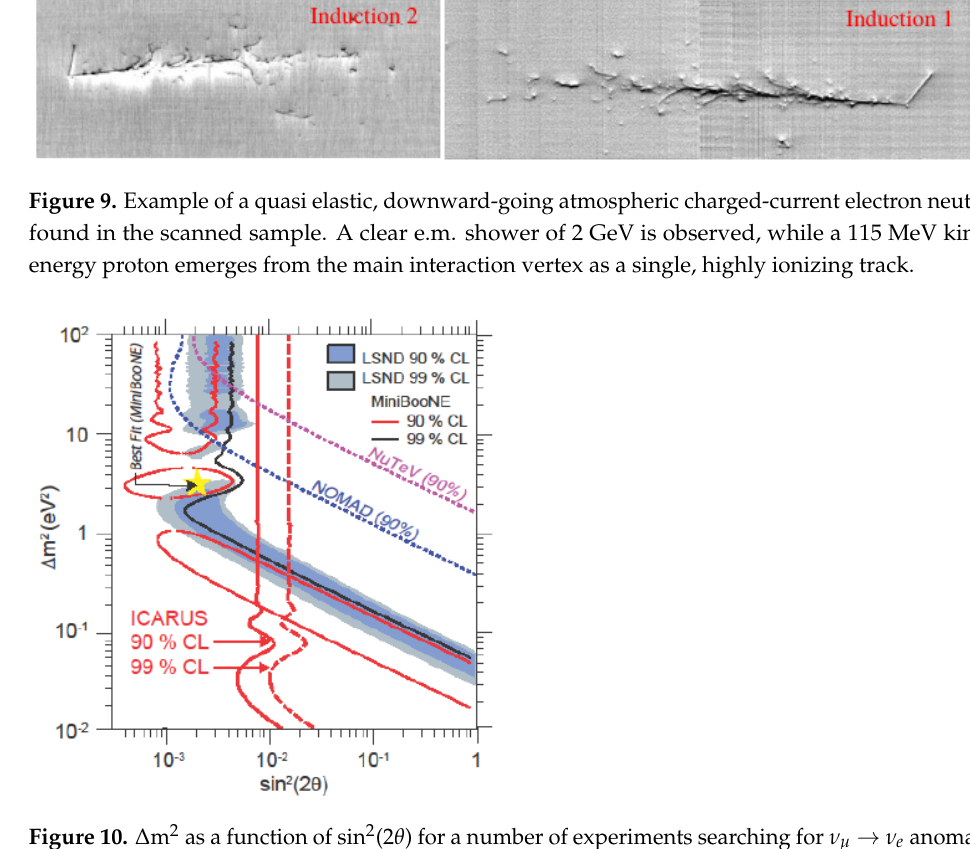
Figure 10. ∆ m 2 as a function of sin 2 (2 θ ) for a number of experiments searching for ν µ → ν e anomalies, overlapped with the ICARUS-T600 90% (continuous red line) and 99% (dashed red line) exclusion limits. The best fit point of MiniBooNE [38] at that time (2013) is indicated with a yellow